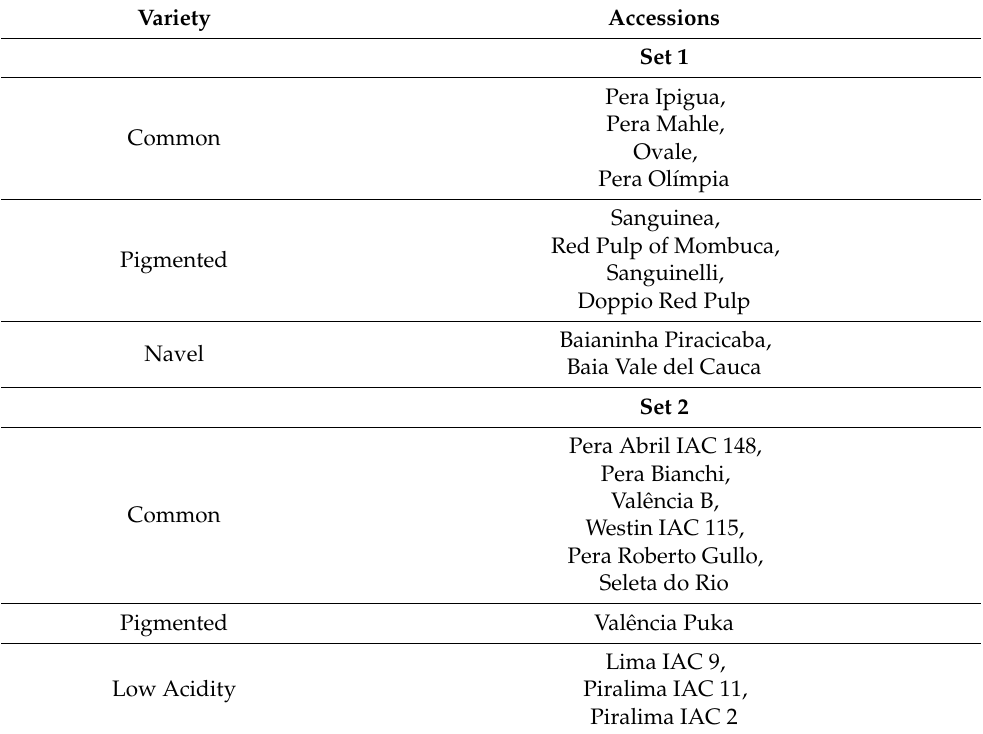
Table 10. Set 1 of sweet orange accessions of the Common, Pigmented, and Navel varieties and set 2 of sweet orange accessions of the Common, Pigmented, and Low Acidity varieties analyzed by LIBS. Variety Accessions Common